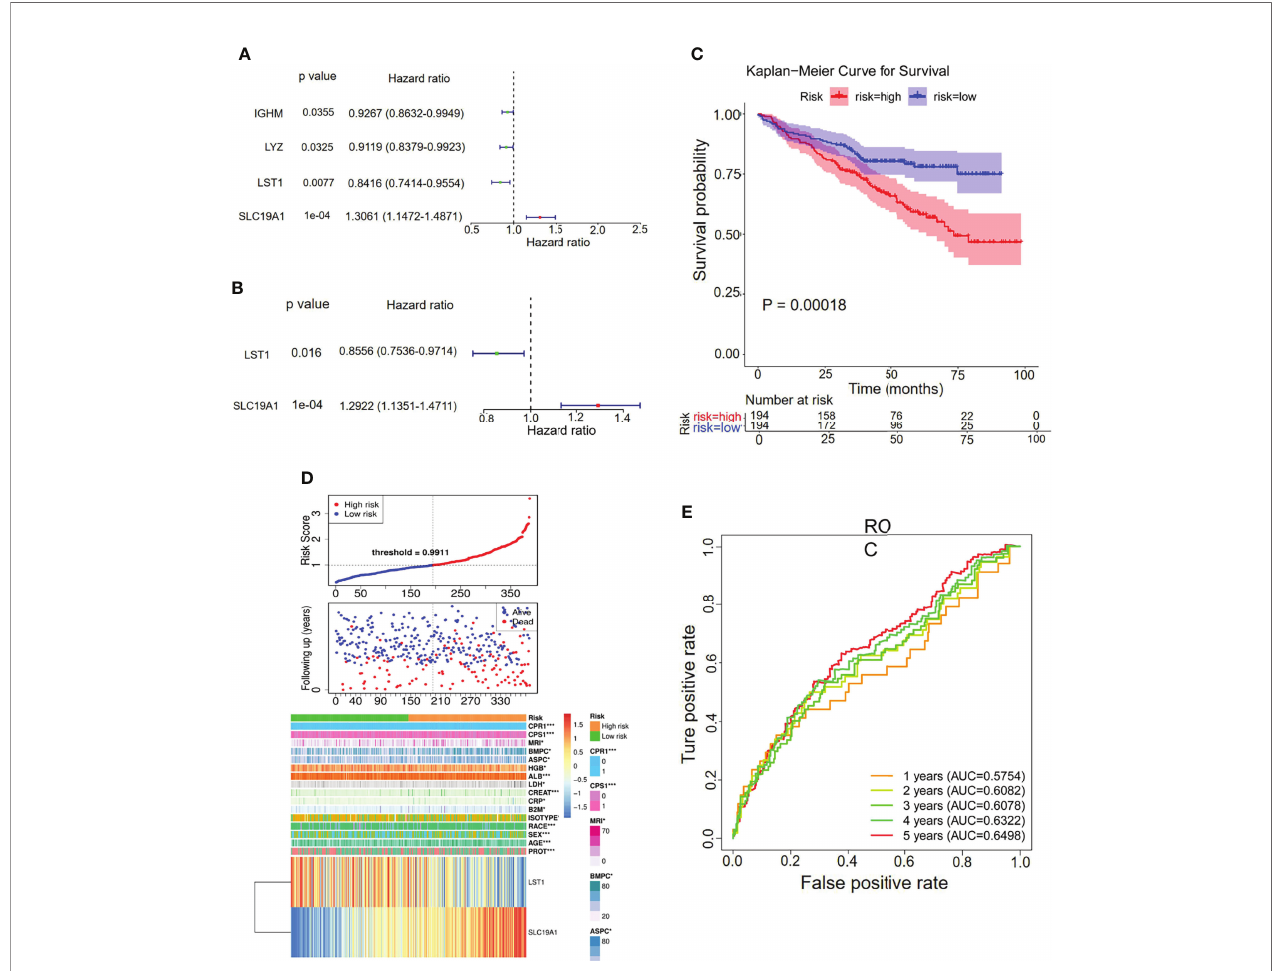
FIGURE 5 | Univariate and multiple stepwise Cox regression analyses of the hypoxia – immune-related genes in MM. (A , B) Multivariate Cox regression analysis of the genes IGHM, LYZ, LST1, and SLC19A1. (C) Kaplan – Meier analysis of the risk score model based on SLC19A1 and LST1 to predict patient survival in the internal training set. Upper: Kaplan – Meier curve. Lower: the number of patients at different time points. (D) The risk score distribution and the survival status. According to the cutoff value, patients with multiple myeloma were divided into high- and low-risk groups. (E) Time-dependent ROC curves for the two-gene model to predict patient survival.